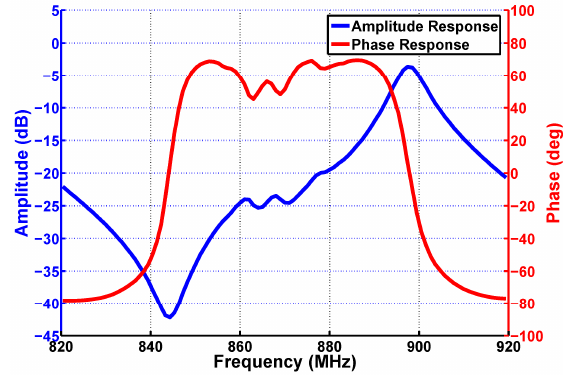
Figure 8. Simulated SAW driving amplifier gain using the measured SAW device S-parameter, including the amplitude-frequency response and the phase-frequency response.